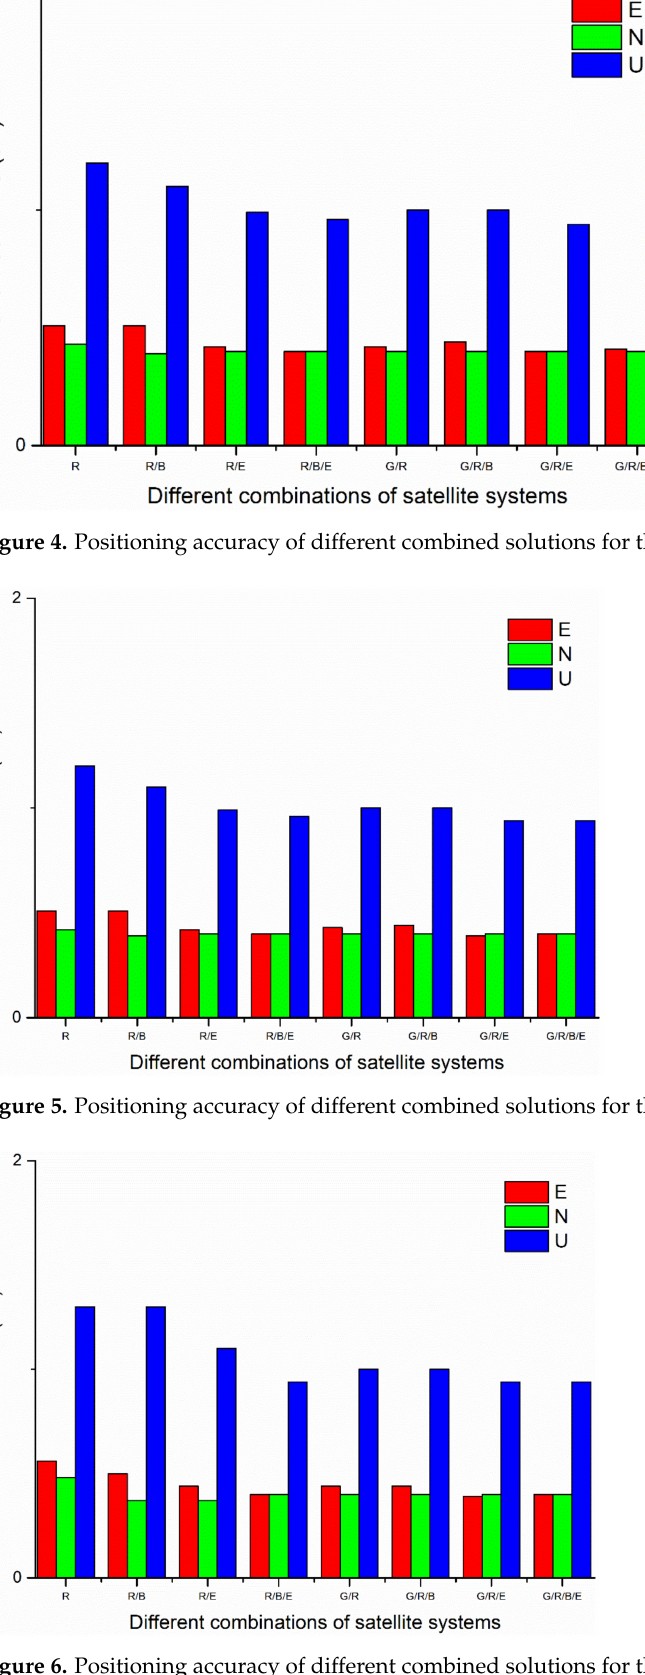
Figure 6. Positioning accuracy of different combined solutions for the EG model in static